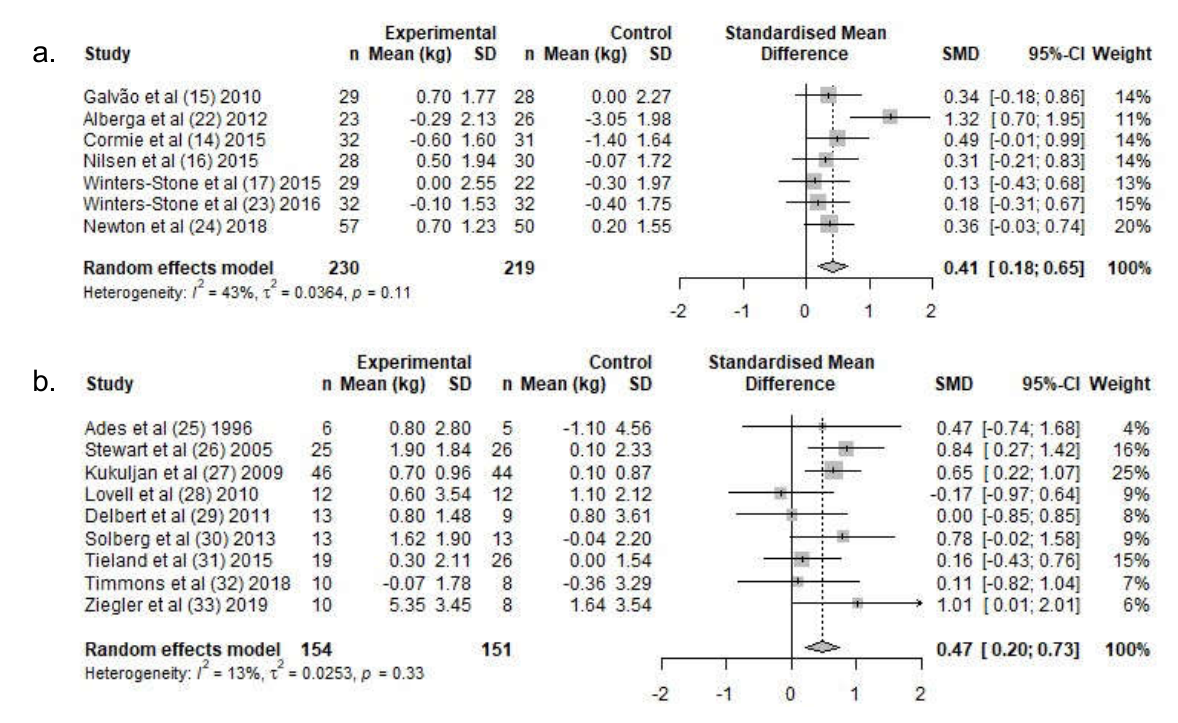
Figure 3. Meta-analysis for change in lean body mass for ( a. ) PCa and ( b. ) HEM. Abbreviations: n , Number; SD, Standard deviation; SMD, standardized mean difference; CI, confidence intervals. Table 3. Within-group changes and comparison of within-group changes between PCa patients and HEM. Prostate Cancer Patients Healthy Elderly Men